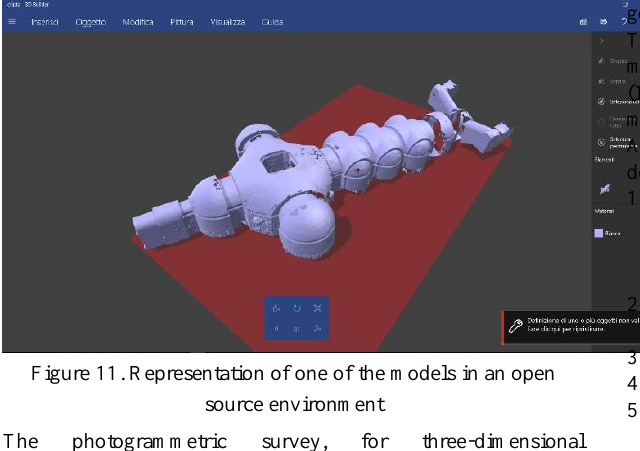
Figure 11. Representation of one of the models in an open source environment The photogrammetric three-dimensional